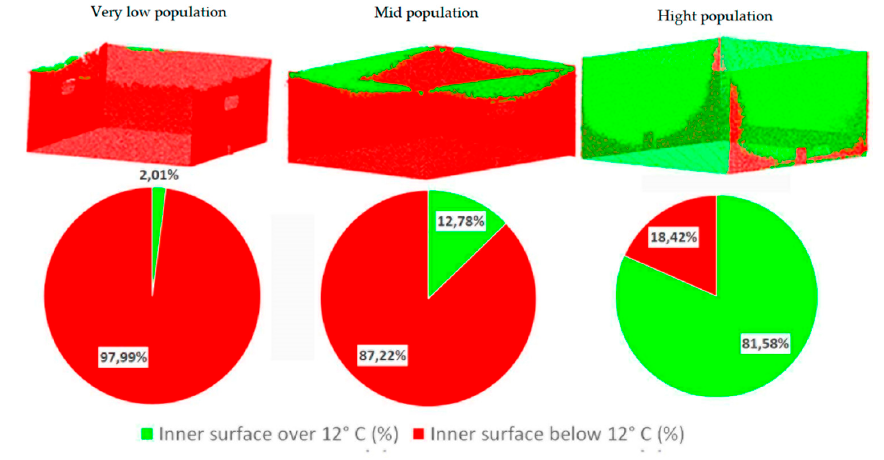
Figure 10. Surface evaluation over pass-through filter results. Very low level of population ( Left ). Mid level of population ( Middle ). High level of population ( Right ).